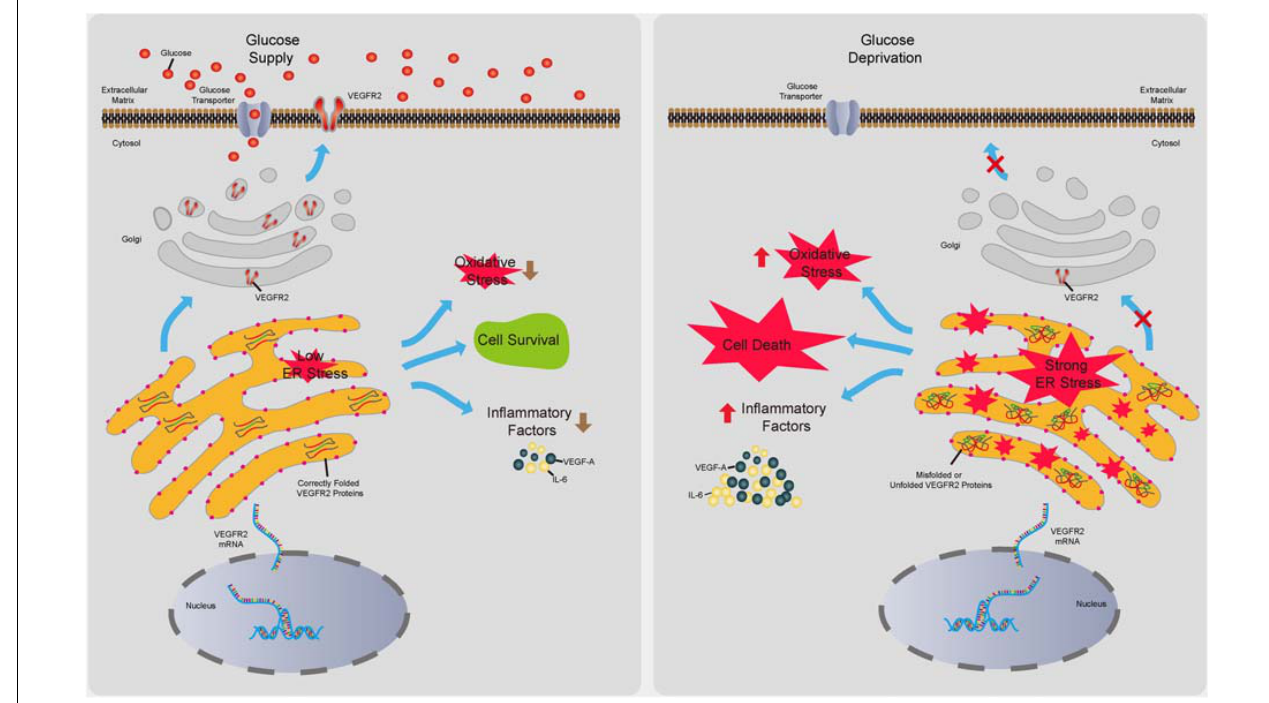
FIGURE 8 | Summary of the novel role of VEGFR2 identified in the current study. In the presence of glucose, VEGFR2 is translated, glycosylated, and folded correctly in the ER lumen and is transported to the cell membrane. Consequently, a normal level of ER stress is maintained, resulting in cell survival and lower levels of oxidative stress and inflammatory factor expression. Under glucose deprivation, under-glycosylated VEGFR2 is incorrectly folded and trapped in the ER, which gives rise to a higher level of ER stress. Expectedly, it triggers cell death and increased oxidative stress and inflammatory factor expression.